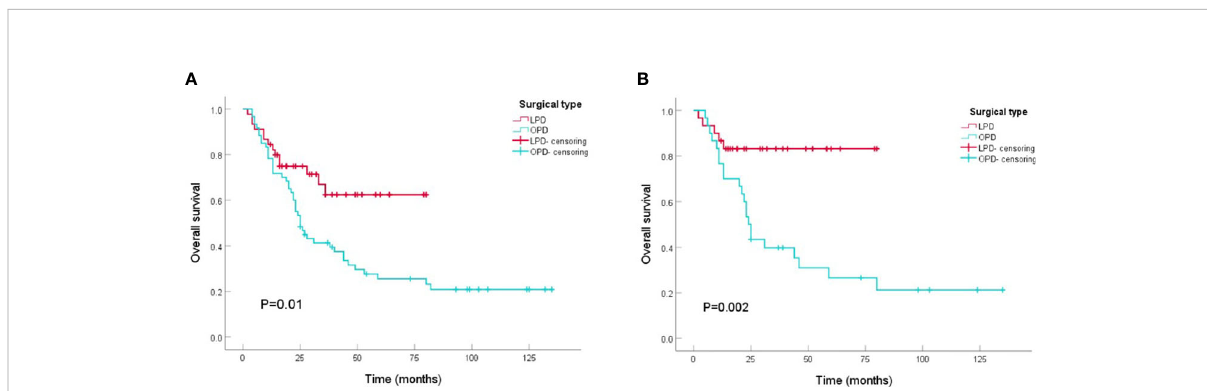
FIGURE 2 Kaplan-Meier curves of overall survival between patients with OPD and LPD. (A) Kaplan-Meier curves of overall survival between patients with OPD and LPD in the original cohort. (B) Kaplan-Meier curves of overall survival between patients with OPD and LPD in the PSM cohort.